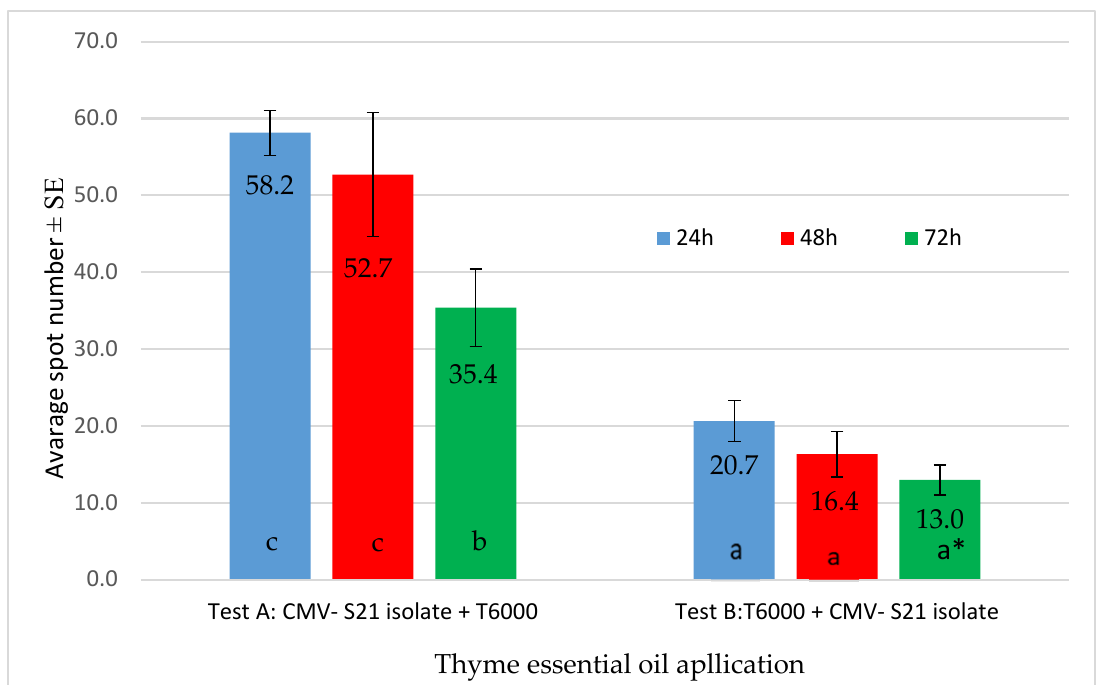
Figure 2. In vivo antiviral effect of thyme EO (6000 ppm) on the infectivity of the CMV-S21 isolate on Ch. quinoa plants. * homogenous group according to the Student–Newman–Keuls test. Values marked with the same letter in a bar do not differ statistically at the significance level p = 0.05.